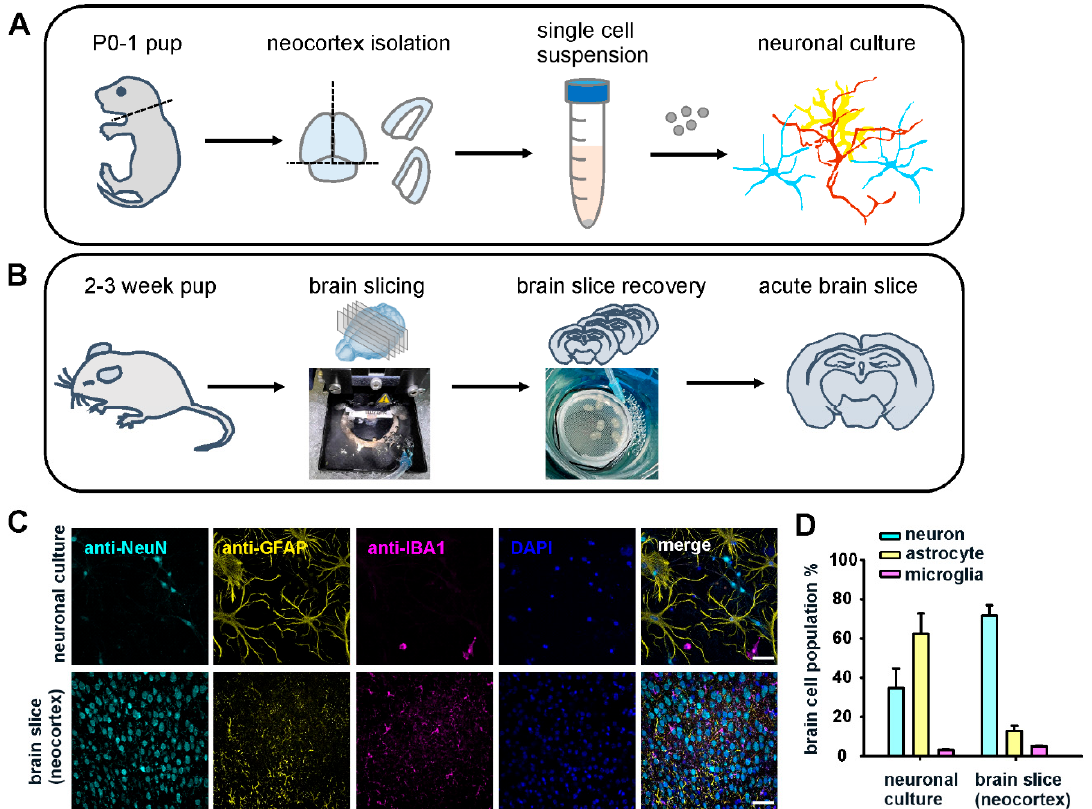
Figure 1. Schematic illustration of neuronal culture and acute brain slice preparation and brain cell composition in cell culture and neocortex. ( A ) Neuronal cells were isolated from the neocortices of postnatal day 0 or day 1 WT pups. A single-cell suspension was obtained after tissue digestion with papain. Finally, the cells were seeded on collagen-coated glass coverslips and cultured for 8–12 days before use. ( B ) Schematic illustration of acute brain slice preparation. Whole brains were isolated from 2- to 3-week-old pups. Brain slices were cut using a vibratome in ice-cold high sucrose buffer. The brain slices were transferred to artificial cerebrospinal fluid (ACSF) for tissue damage recovery before the experiments. ( C ) Confocal images of neuronal cells in neuronal culture and neocortex from ( A , B ). Day 8 neuronal cells and acute brain slices after recovery were fixed and stained with anti-NeuN, anti-GFAP, and anti-IBA1 antibodies to label neurons, astrocytes, and microglia, respectively. Cell nuclei were labeled with DAPI. Scale bar: 50 µm. ( D ) Quantitative analysis of brain cells in cell culture and neocortex from ( C ). Cell counting analysis in both the cell culture and brain slice groups was performed from two independent preparations (N = 2; n = 1249 for cell culture and n = 1036 for brain